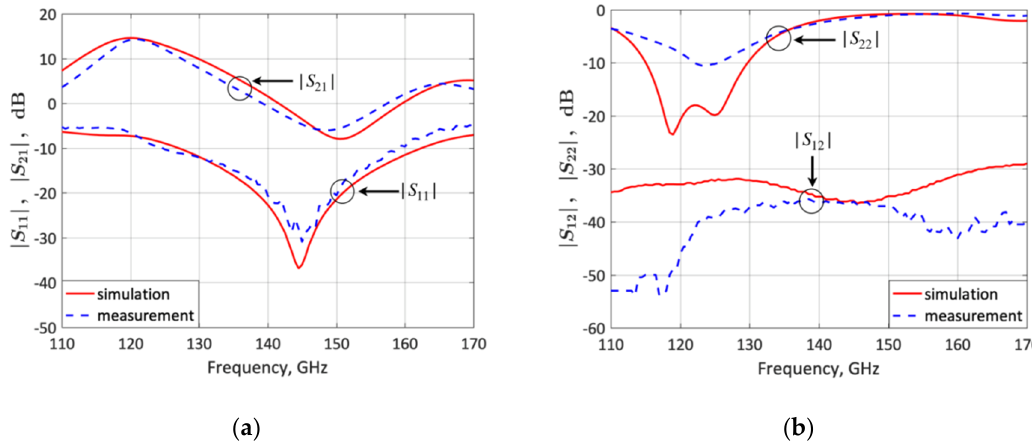
Figure 9. Measured and simulated LNA S -parameters for the lower-frequency state (120 GHz). ( a ) S 21 and S 11 ; ( b ) S 12 and S 22 .